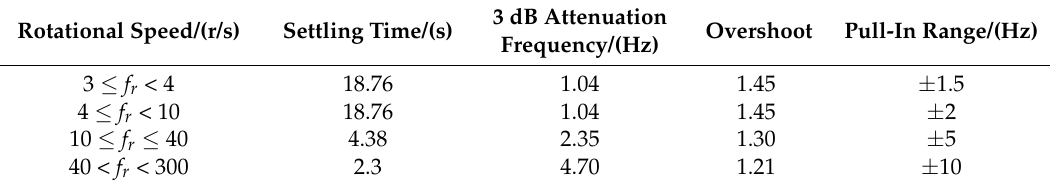
Table 2. Performance index of FLL-assisted